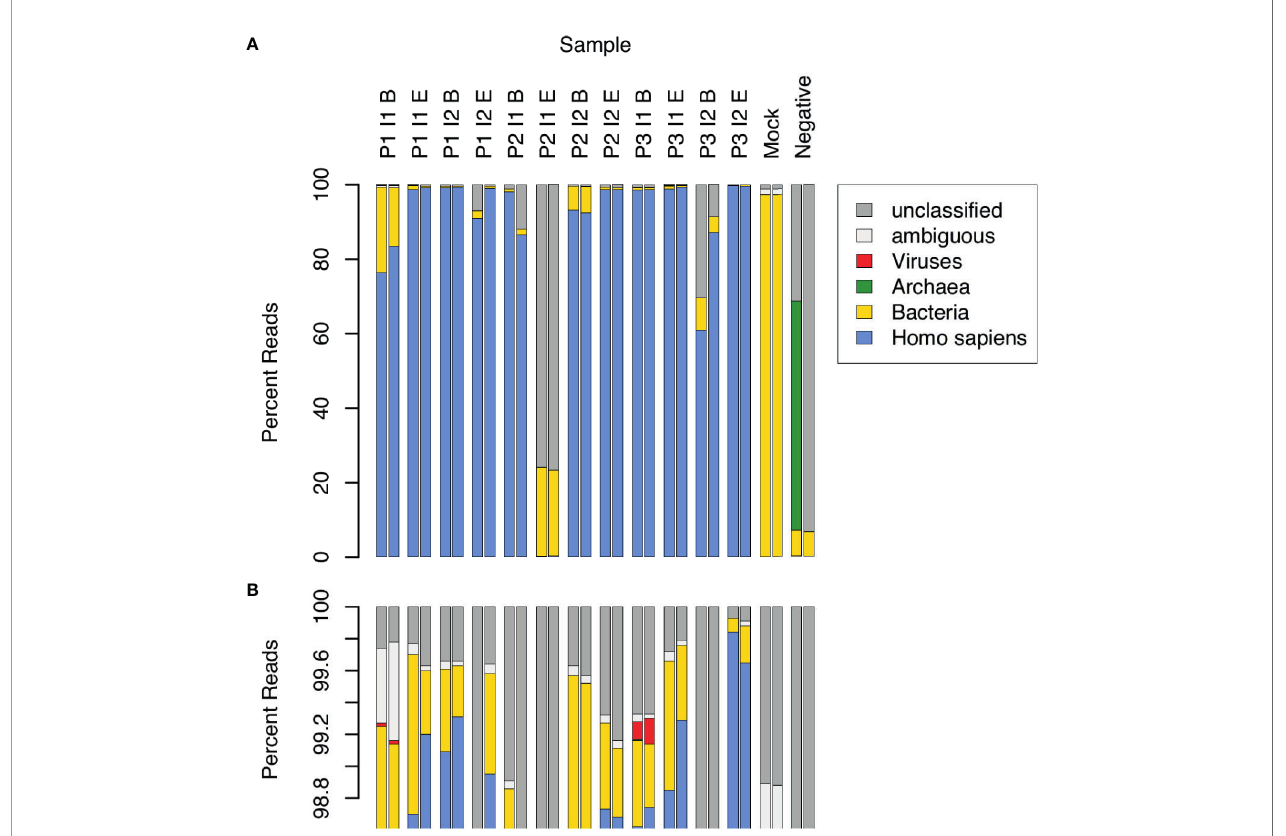
FIGURE 1 | Relative abundance of sequence reads in CSF samples across major domains of life. 12 CSF samples were analyzed in duplicate by WGA. The samples came from 3 patients (P1, P2, P3), each having 2 infection episodes (I1, I2), with one sample collected near the beginning (B) and the other near the end (E) of the episode. Control samples consisted of a mock bacterial community (Mock) and a negative, no-template sample (Negative). Assignment of sequence reads to major domains of life was performed with Kraken: human (blue), bacteria (yellow), archaea (green), viruses (red), ambiguous, i.e. assignment to more than 1 domain (white), and unclassi fi ed, i.e. not assigned to any domain (grey). The lower panel (B) is an expanded view of (A) , showing the top percentile range and revealing 2 samples in which viral sequences were